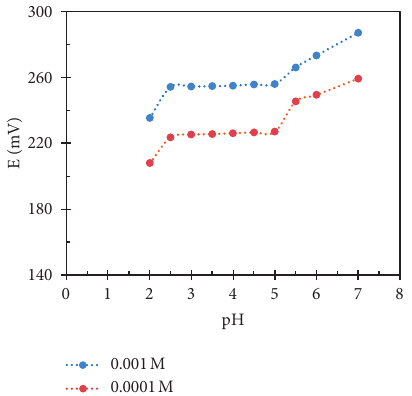
Figure 3: Effect of pH on potentiometric response for the DES.RNK